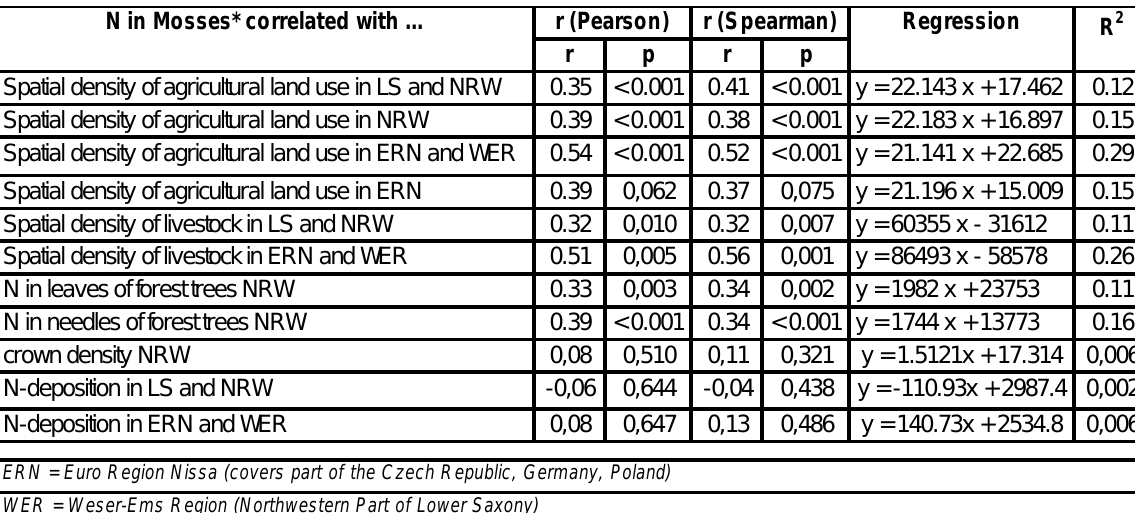
Spatial density of agricultural land use in LS and